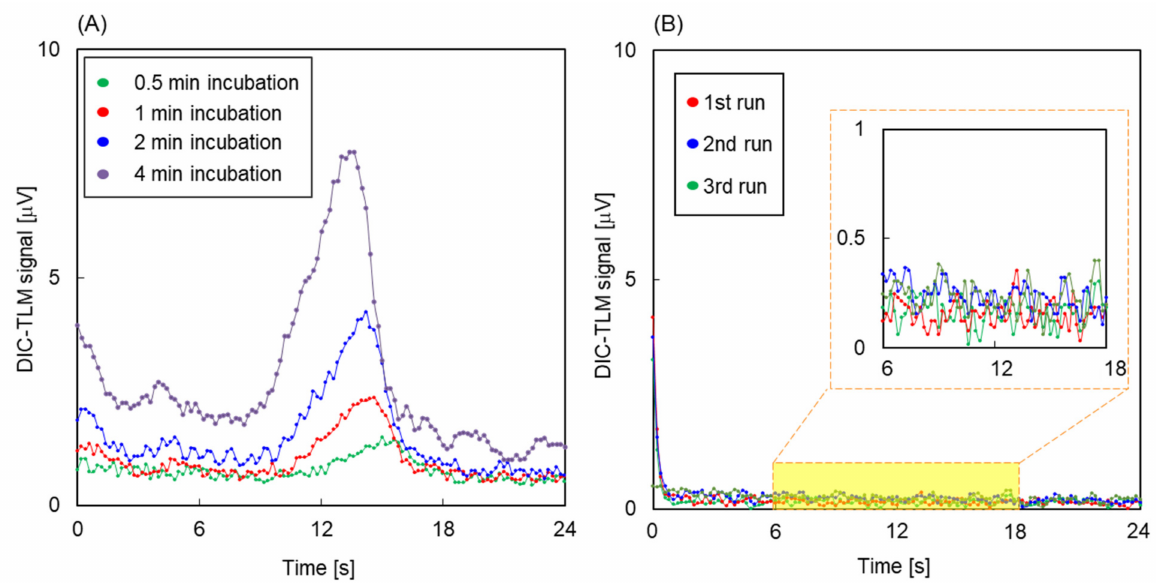
Figure 6. ( A ) DIC-TLM signals during 24 s flow with different incubation times for device 1. ( B ) DIC-TLM signals during 24 s flow in the 3 times experiments.